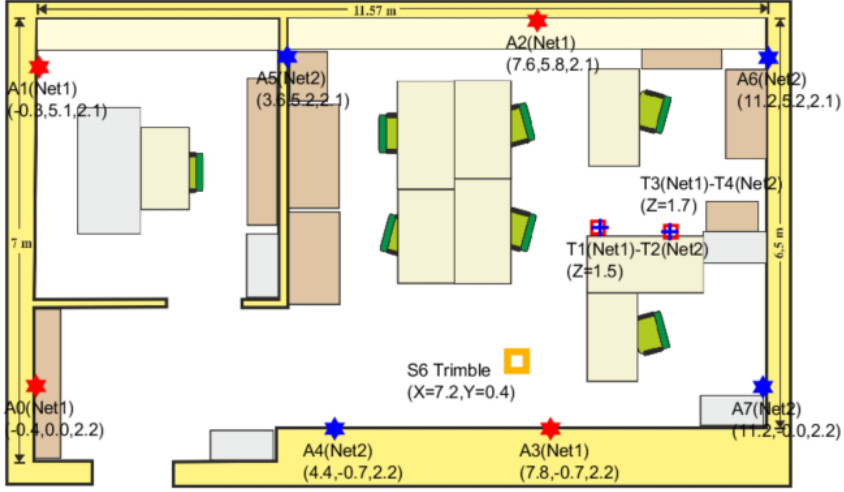
Figure 10. Test environment map-layout. The six-pointed stars indicate the eight anchors distributed in two interleaved sub-networks (Network1 in red, and Network2 in blue). T1-2 and T3-4 are two pairs of tags in static condition. The location of the Trimble S6 total station is marked in orange. The previous Figure 9 is a view of our lab from point A7 (bottom right corner).